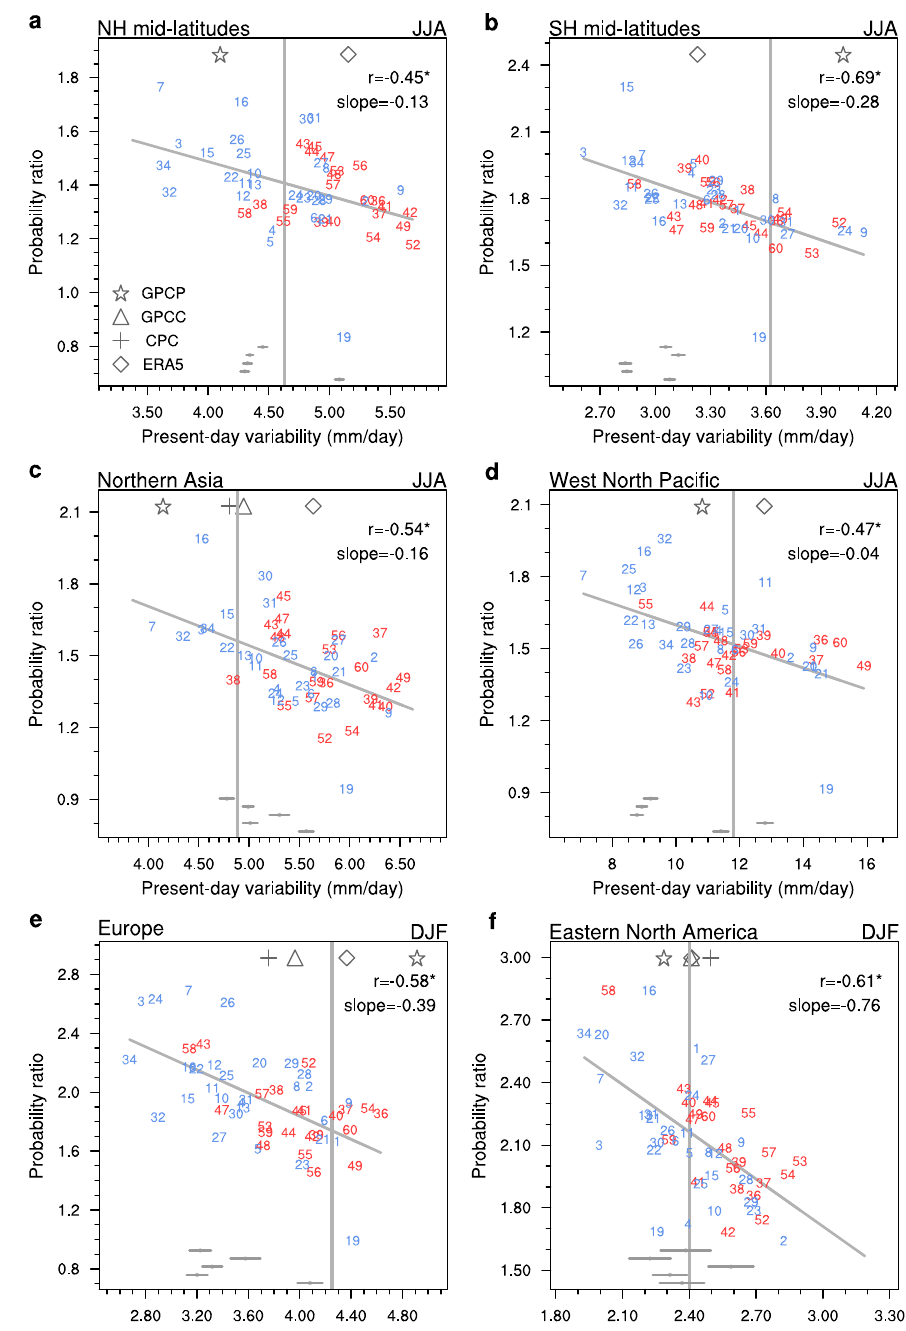
Fig. 2 | The emergent relationship over typical regions. Scatterplots of the present-day precipitation (pr5d) variability and the probability ratio of extreme precipitation (95th percentile of pr5d) changes under a 3°C global warming increment in the joint ensemble of CMIP5 and CMIP6 (Coupled Model Inter- comparison Project Phases 5 and 6). Regional cases include: Northern hemisphere mid-latitudes (45° − 70°N) in June-to-August (JJA; a ), Southern hemisphere mid- latitudes (45° − 70°S)inJJA( b ),NorthernAsiainJJA( c ),West NorthPaci fi cinJJA ( d ), Europein December-to-February (DJF; e ) and Eastern North America in DJF( f ).See